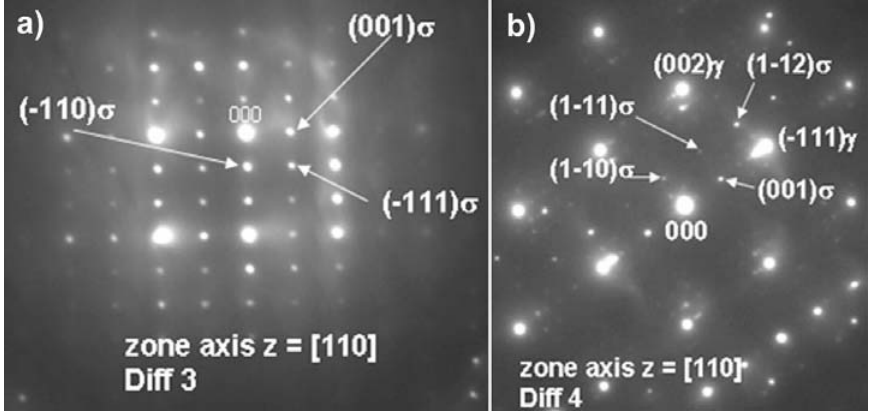
-spacing and lattice parameters for σ phase in the (hkl)